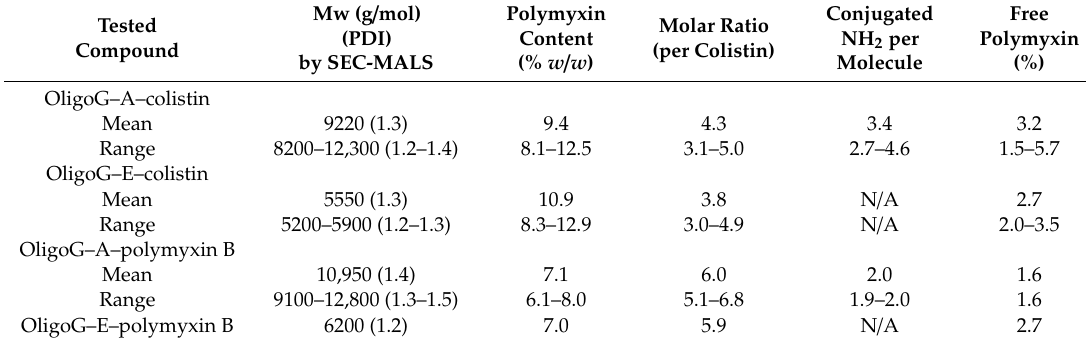
Table 1. Summary of the properties of the OligoG-polymyxin conjugates synthesised in this study. Tested